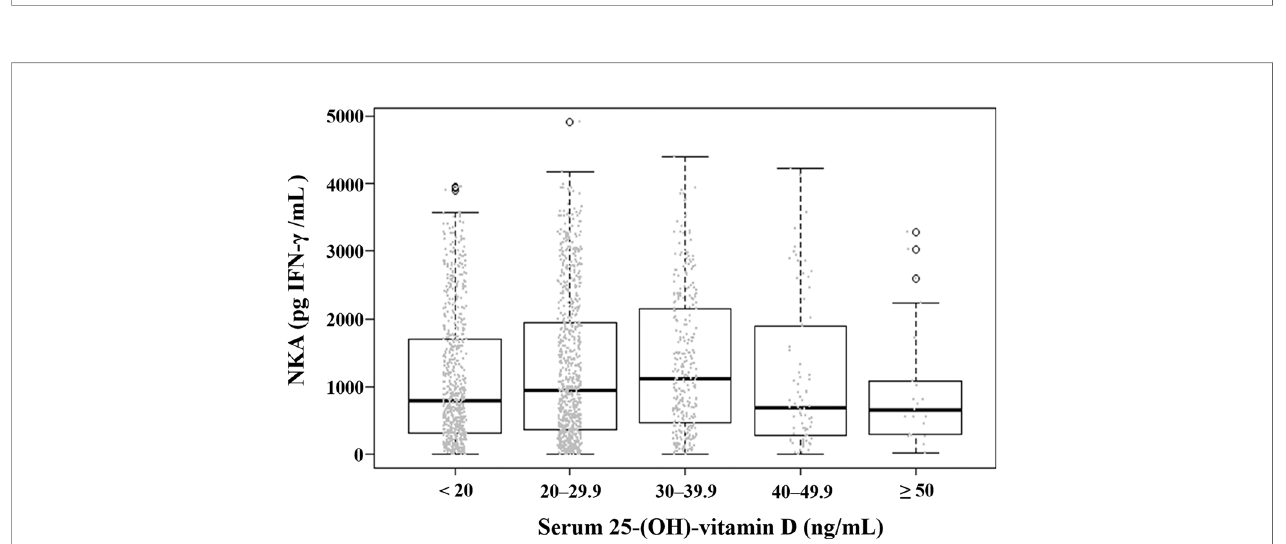
FIGURE 3 | Distribution of natural killer cell activity value according to serum level of 25-(OH)-vitamin D. Each dot represents the individual value of natural killer cell activity. Box plots show group medians, interquartile range (IQR), and spread of data with outliers for each group. NKA, natural killer cell